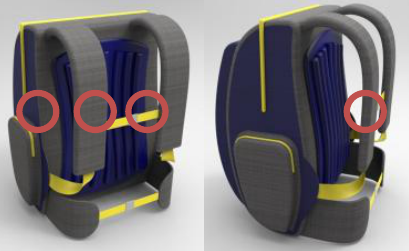
Figure 11. 3D model of the whole ergonomic backpack Figure 12. Placement of the mechanism inside the shoulder straps and back